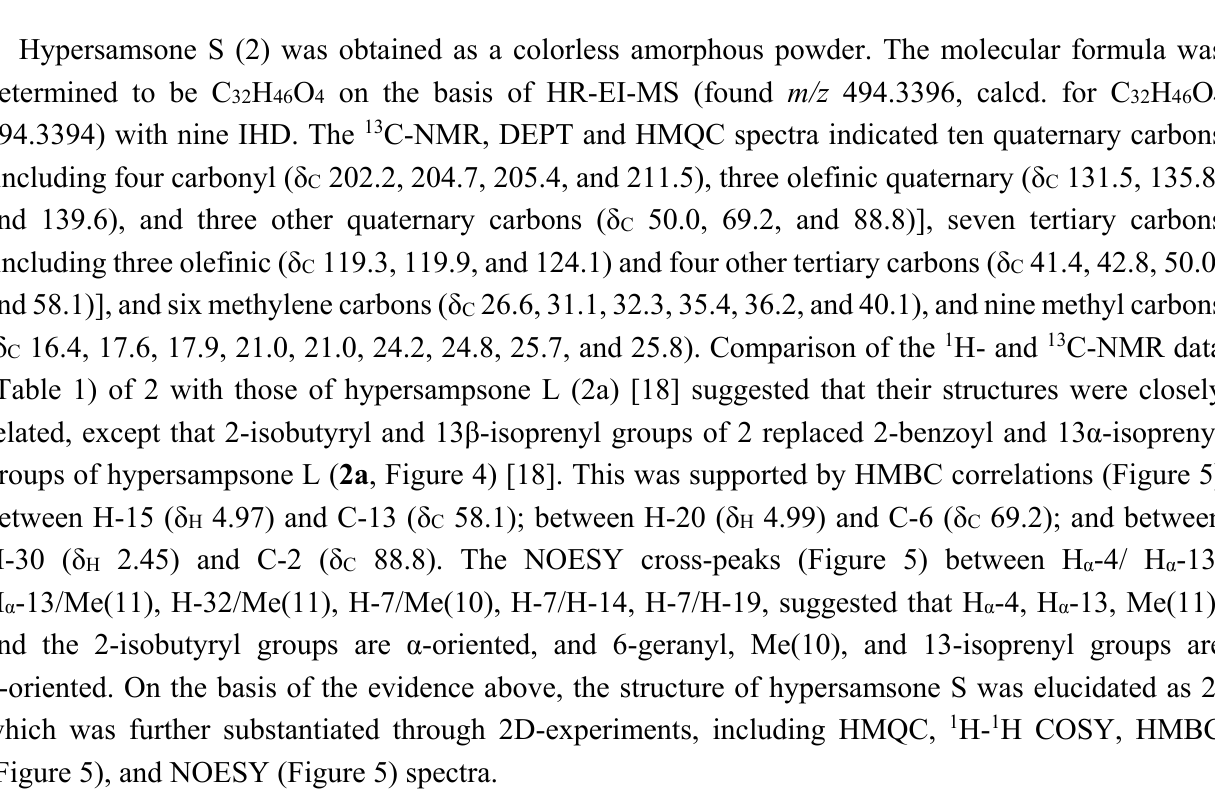
Figure 4. The chemical structure of hypersampsone L ( 2a